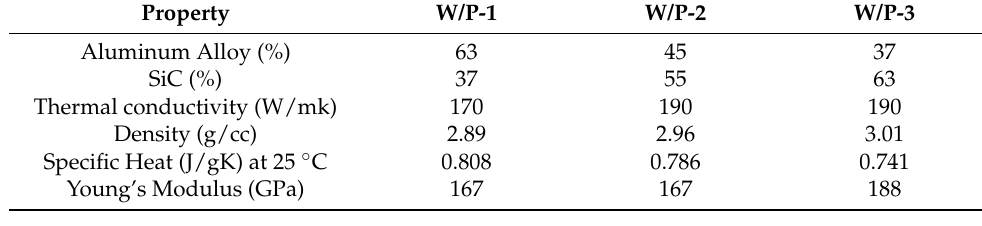
Table 1. MMCs properties (Source: CPS Tech, Norton, MA, USA).